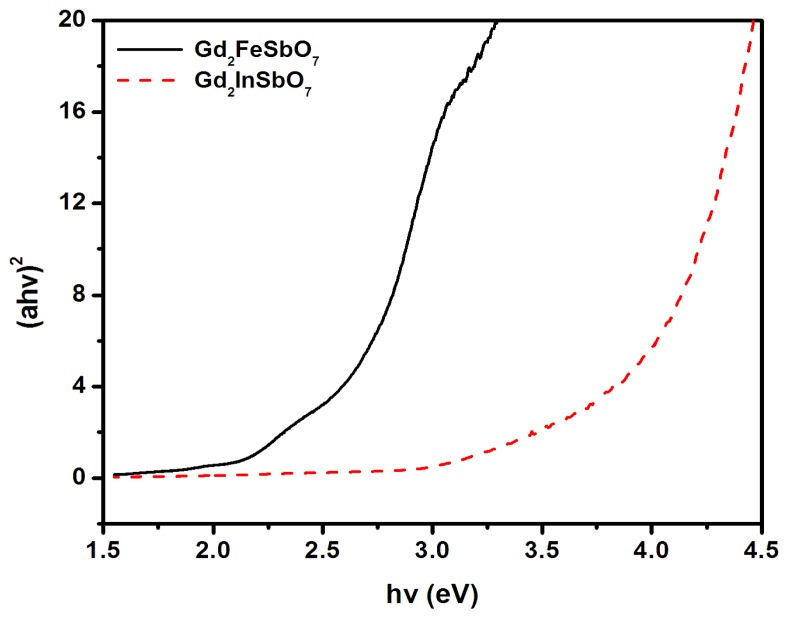
Plot of (αhν)2versus hν for Gd2FeSbO7 and Gd2InSbO7.